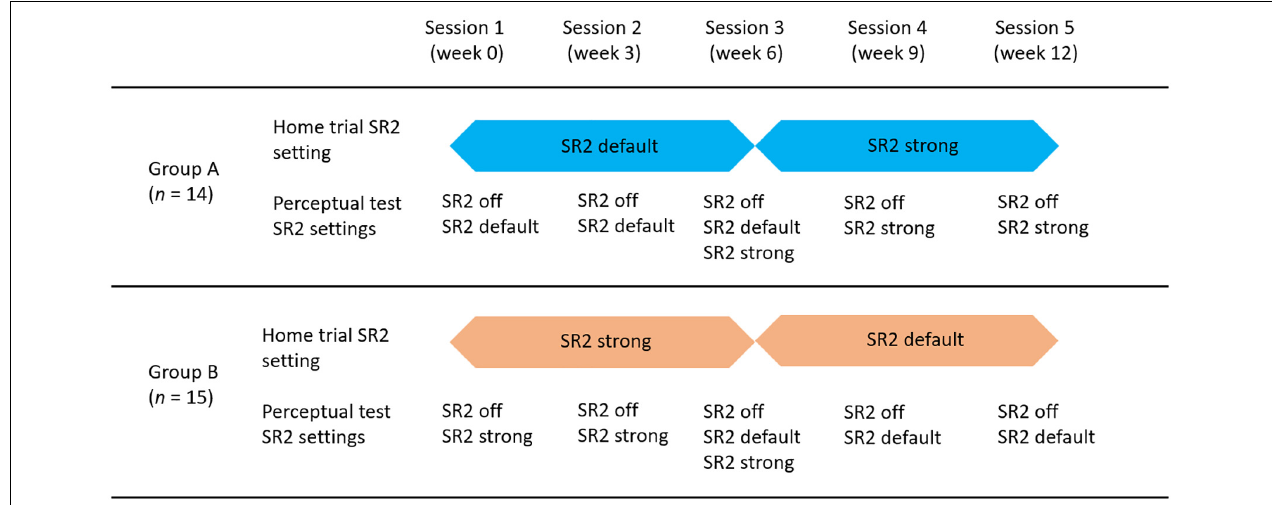
FIGURE 3 | Diagram of test procedures and group assignments. There were 5 sessions equally distributed in the 12-week period. Participants were randomly assigned into two groups. Group A ( n = 14) used SR2 default as the home trial setting for the first 6 weeks and switched to SR2 strong for the home trial in the second 6 weeks. Group B ( n = 15) used SR2 strong for the first 6 weeks and SR2 default for the second 6 weeks in their home trial.